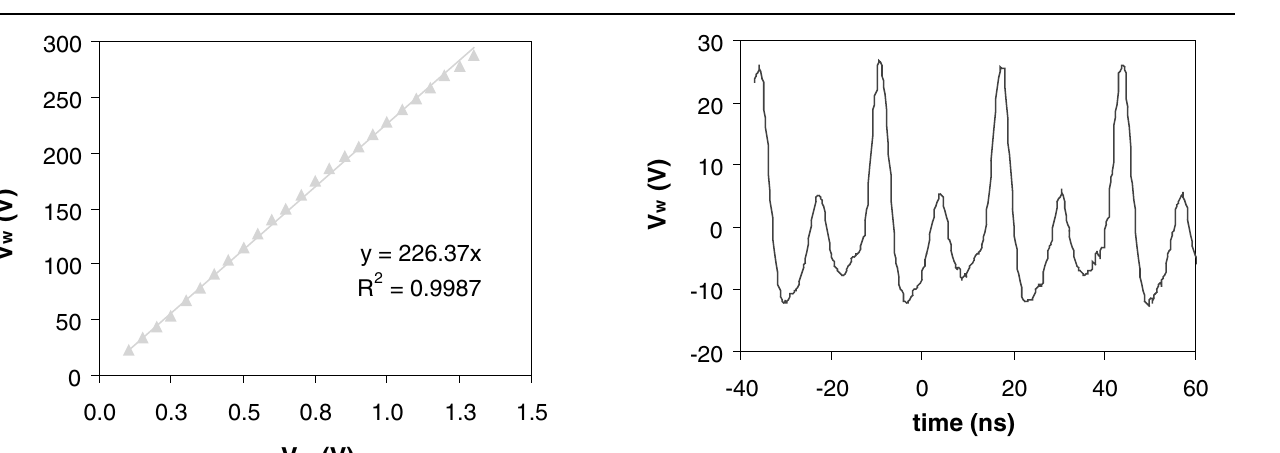
FIG. 16. Voltage amplitude detected in the RP as a function of time. The significance of the two sets of peaks is as follows: FIG. 15. RR behavior as a function of the peak voltage given The larger peaks are due to pulse addition, and the smaller ). The green triangles represent the by the signal generator ( V SG peaks are the result of the unavoidable reflections, which calculation of the voltage value taking into account an attenu- circulate in the opposite sense ( (cid:4) T (cid:1) 26 : 6 ns , t ation for the RP of (cid:4) 43 : 44 dB . As can be seen from the R -squared value, the voltage at the RP varies linearly within (cid:1) . The measurement does not go beyond V the range of V SG SG 1 : 3 V because multipacting is (cid:1) 1 : 3 V be- ation of (cid:4) 43 : 44 dB ). The data stop at V SG